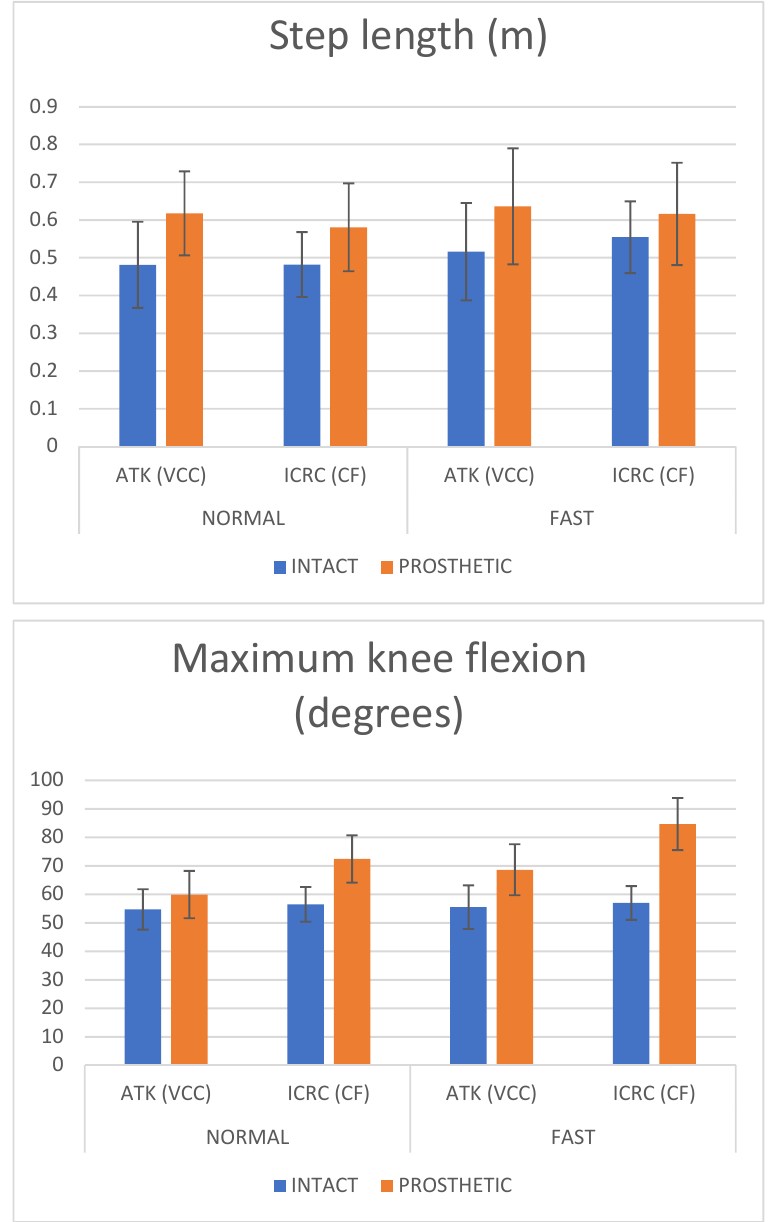
Figure 4. Swing time, step length and knee flexion maximums for the prosthetic and intact sides for the normal and fast walking speeds. Mean values and one standard deviation shown. Table 1. Participant characteristics.